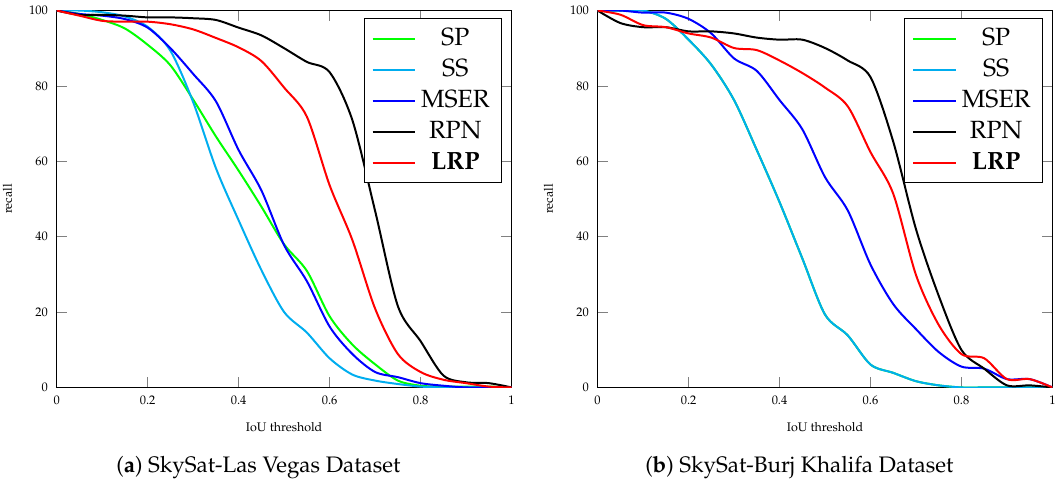
Figure 9. Recall rates over different IoU